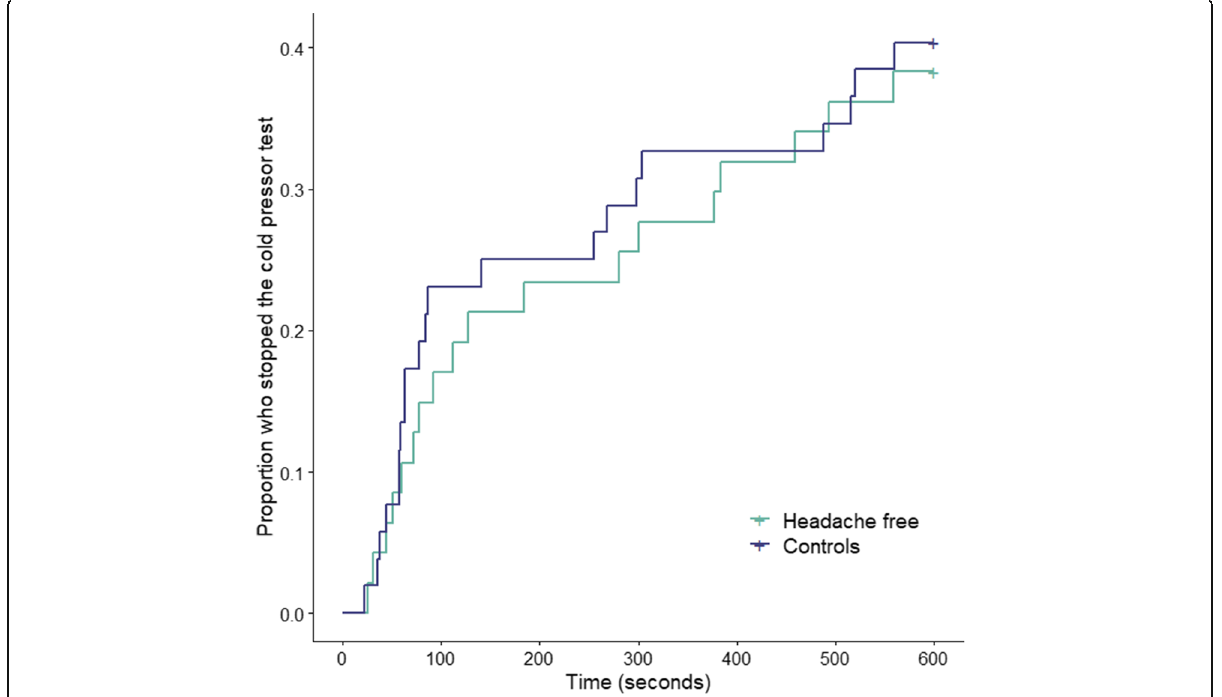
Fig. 3 Pain tolerance. Proportion of headache free participants and controls who stopped the cold pressor test over